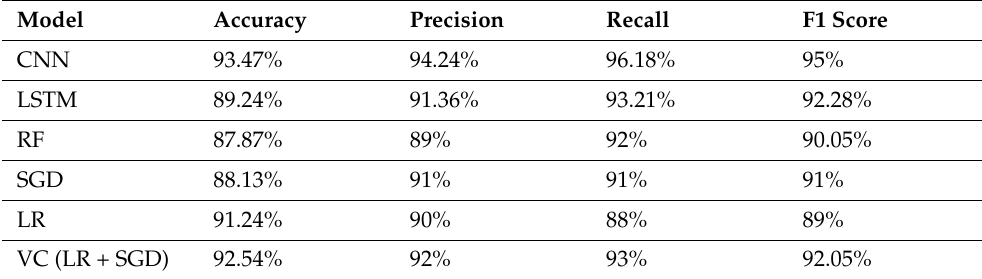
Table 6. Experimental results using the combined features.